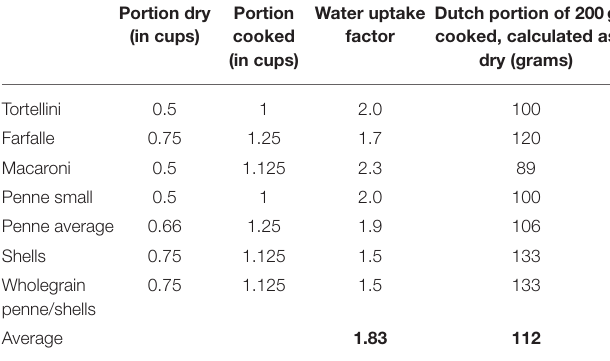
TABLE 1 | Dutch recommended daily intakes of carbohydrate-rich products, including wholegrain products such as pasta and rice (29).